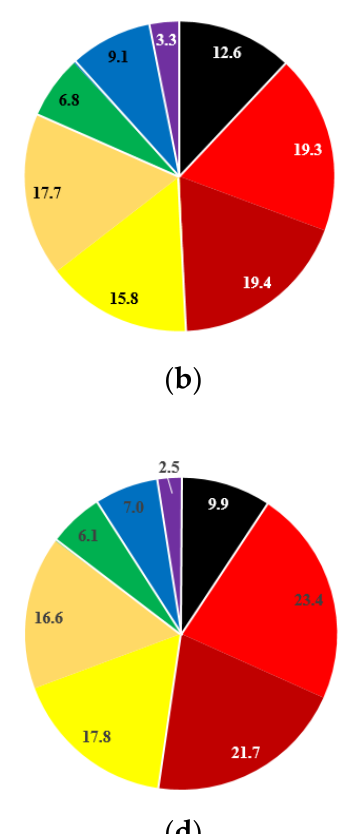
Table 6. Diagnostics Ratio (DR) for anlaysis.